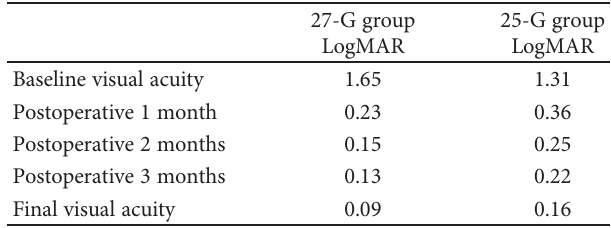
Table 2: Changes of visual acuity in patients with primary anatomical